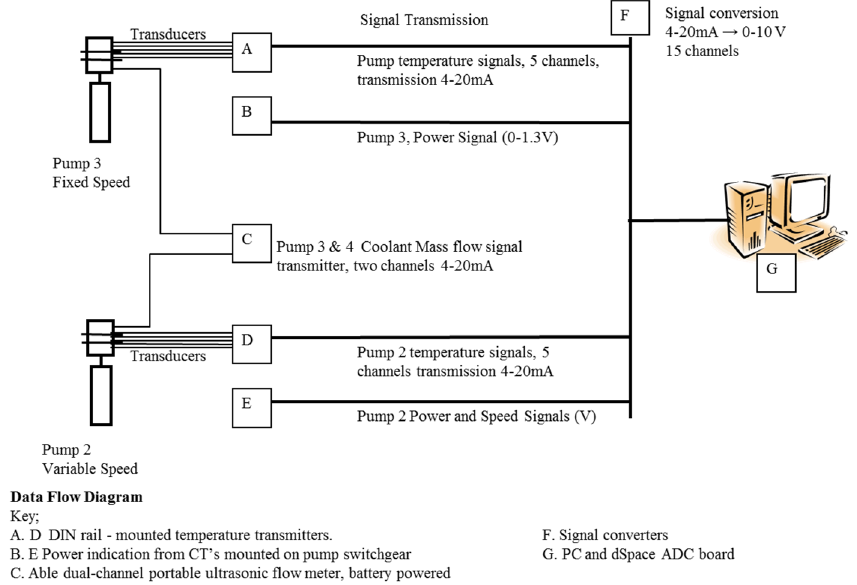
Figure 13. I / O Schedule for online testing of the device Figure 13. I/O Schedule for online testing of the device implementation.